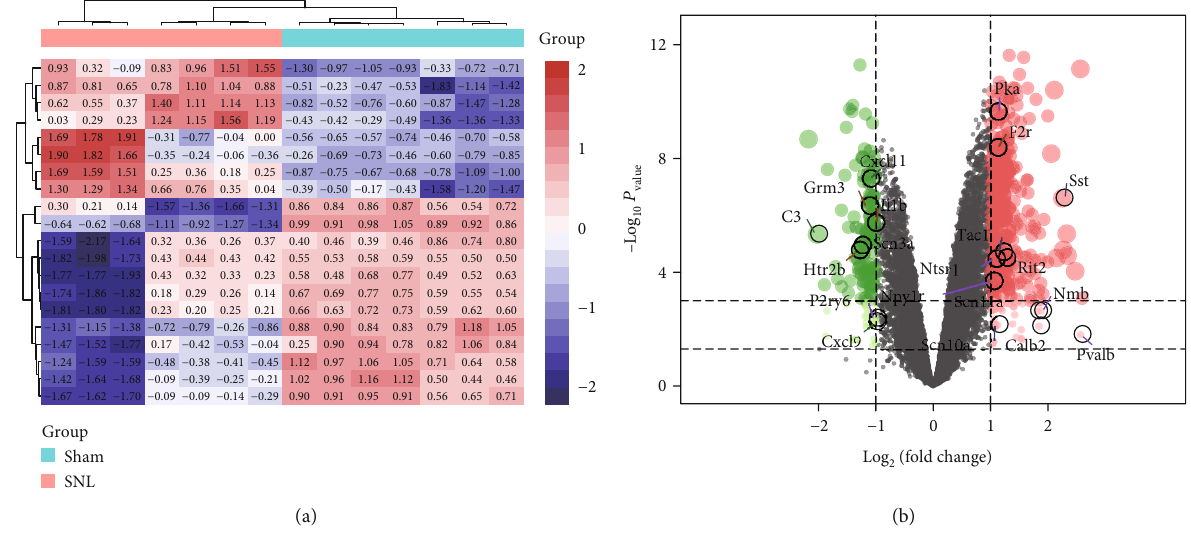
Figure 4: Di ff erential expression of the hub genes. (a) Heat map of the hub genes. Red indicates upregulation; blue indicates downregulation. (b) Volcano map of the hub genes. Red, green, and black dots indicate upregulated, downregulated, and unaltered genes,